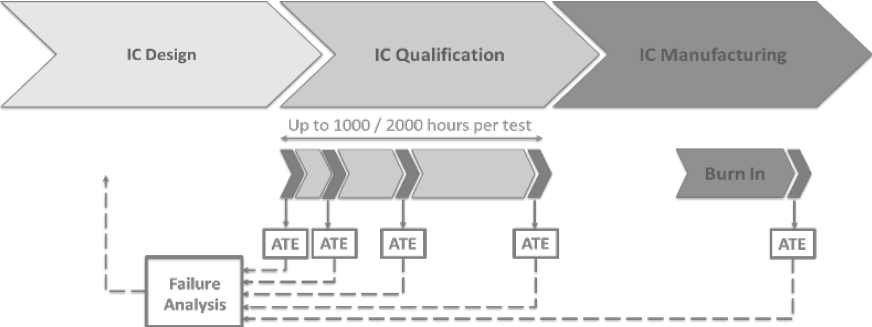
Figure 2. Traditional Approach based on Burn-In.